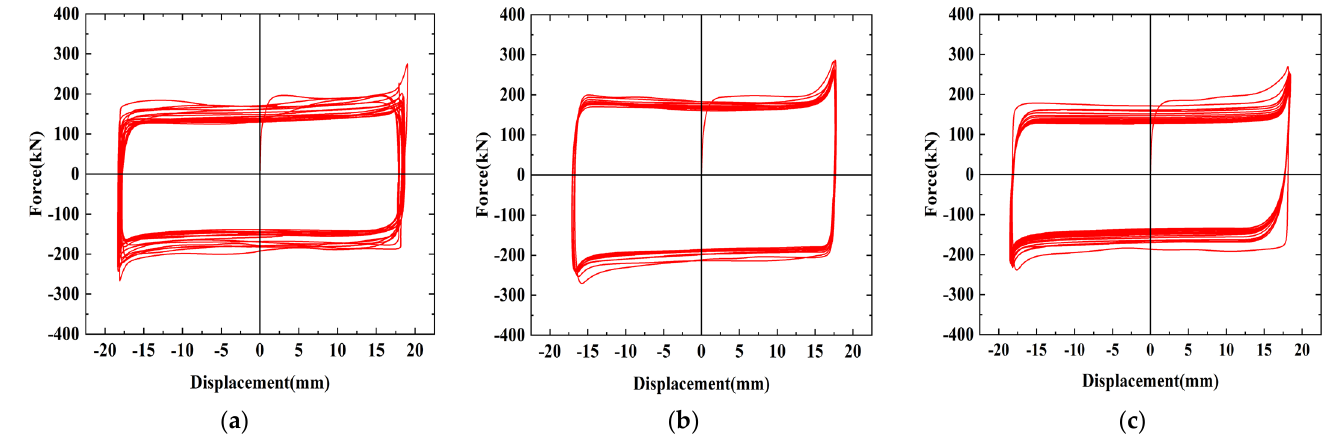
Figure 8. The hysteresis curves of different numbers of bolts: ( a ) SJ1, with 22 bolts; ( b ) SJ2, with 30 bolts; ( c ) SJ3, with 16 bolts.